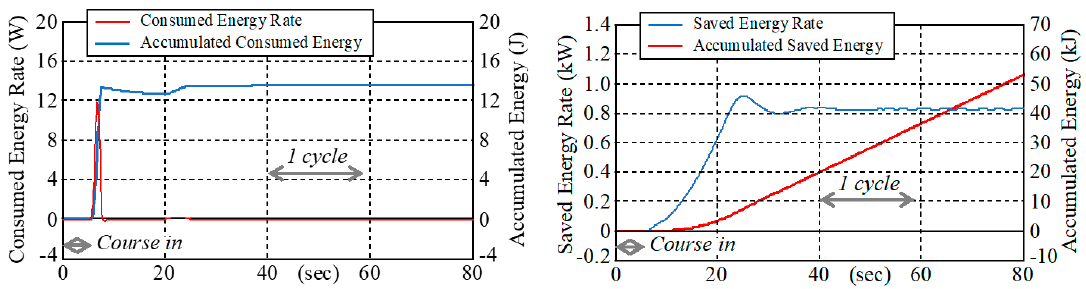
Figure 31. Consumed and saved energy on steady circle.